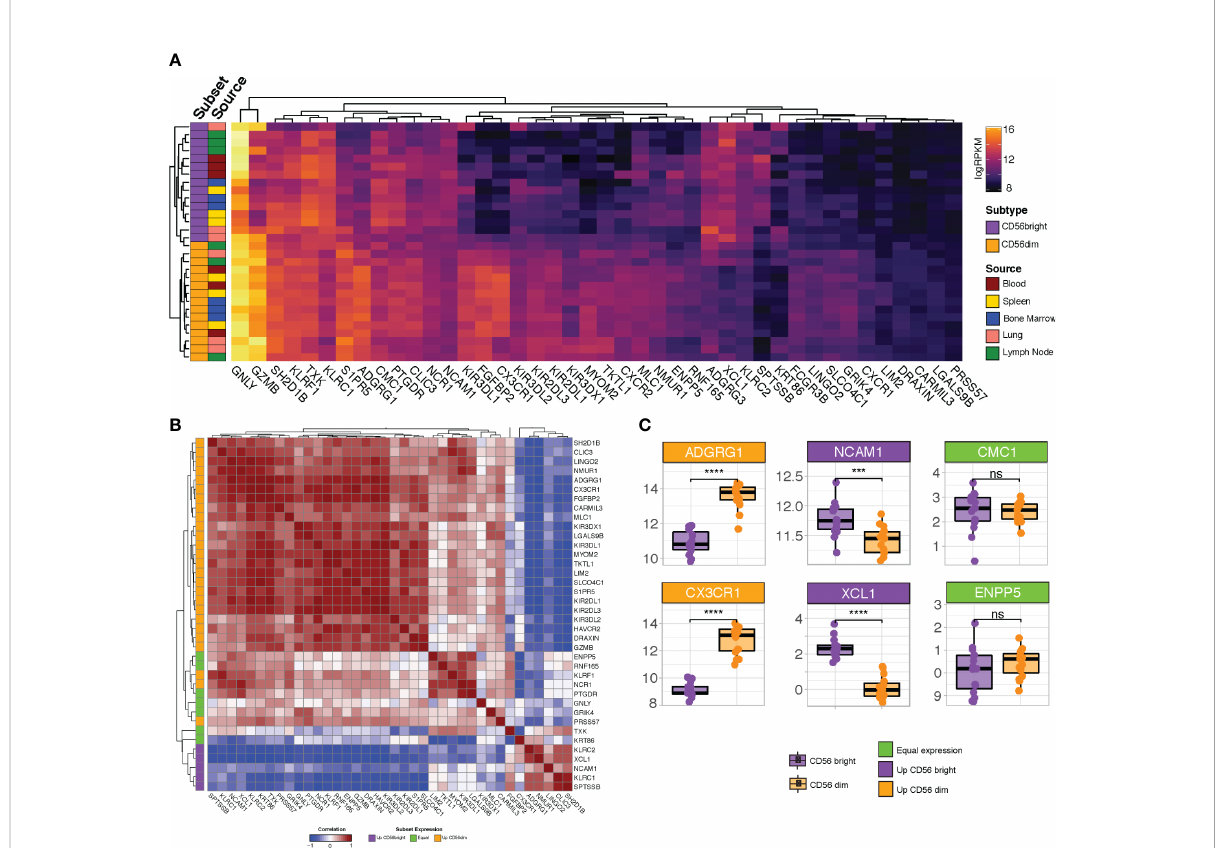
FIGURE 4 Pro fi ling re fi ned gene set expression in NK cell subsets. (A) Heatmap of re fi ned gene set expression in CD56 bright (orange) and CD56 dim (purple) NK cells isolated from the blood (red), spleen (yellow), bone marrow (blue), lung (pink) and lymph node (green) of four healthy donors (GSE133383). (B) Correlation matrix of re fi ned gene set. Genes are annotated (at left) according to whether they show preferential expression in the CD56 dim (orange), CD56 bright (purple) or neither (green) NK cell population (C) Boxplot expression of selected genes in CD56 dim (orange boxplots) vs CD56 bright (purple boxplots) NK cell populations. Headers are coloured based on whether the gene is preferentially expressed in CD56 dim (orange headers) vs CD56 bright (purple headers) NK cells or shows equivalent expression across both subsets (green